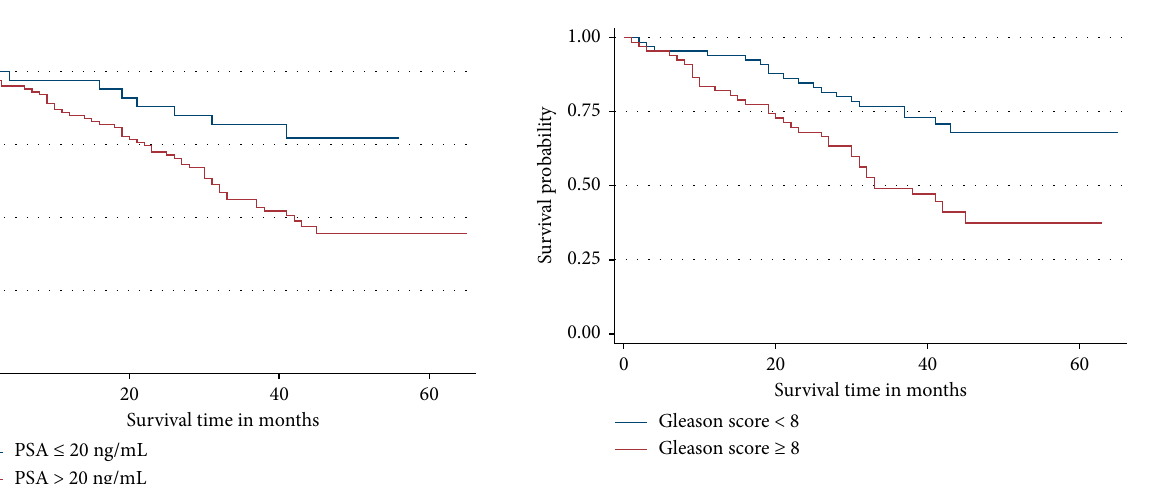
Figure 2: Overall survival by age group of the patients. Patients aged more than 60 years show a relatively increased risk of dying compared to those aged less than 60 years.